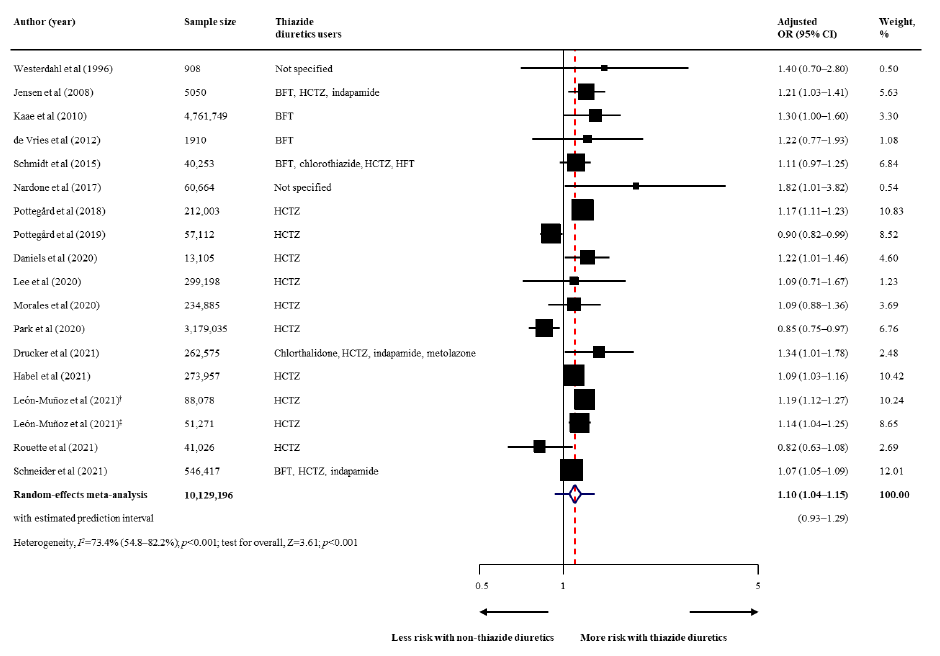
Figure 1. Effect of the use of thiazide diuretics and the risk of malignant melanoma. Abbreviations: BFT, bendroflumethiazide; CI, confidence interval; HCTZ, hydrochlorothiazide; HFT, hydroflume- thiazide; OR, odds ratio [29–31,33,37,38,41,44–46,48,49,52,54,56–58].